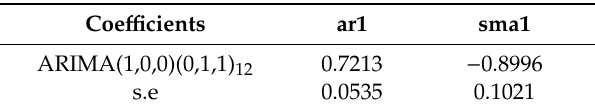
Table 2. Coe ffi cient estimations of ARIMA (1,0,0) (0,1,1) 12 .